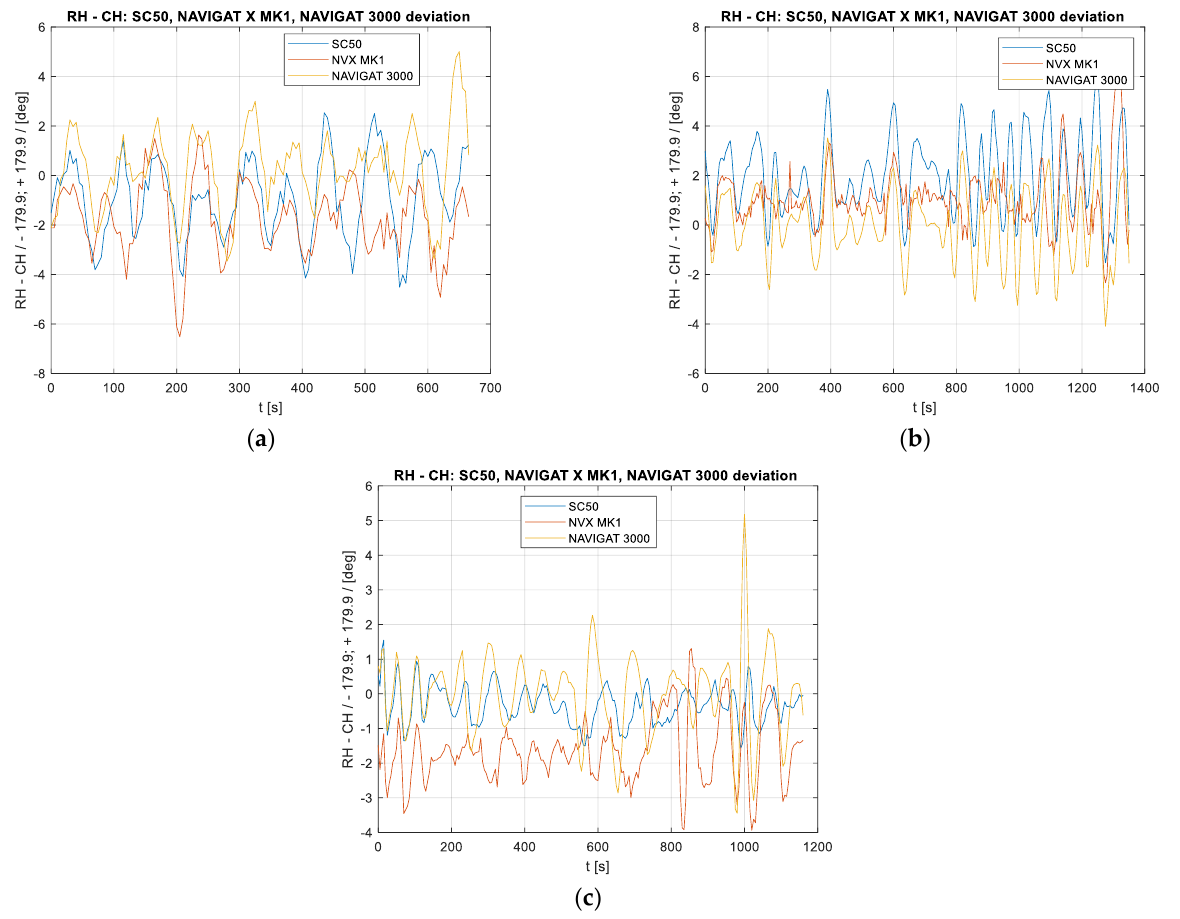
Figure 5. The differences between the course values indicated by the compasses under study and the reference device: ( a ) test #1, ( b ) test #2, and ( c ) test #3. reference device: ( a ) test #1, ( b ) test #2, and ( c ) test